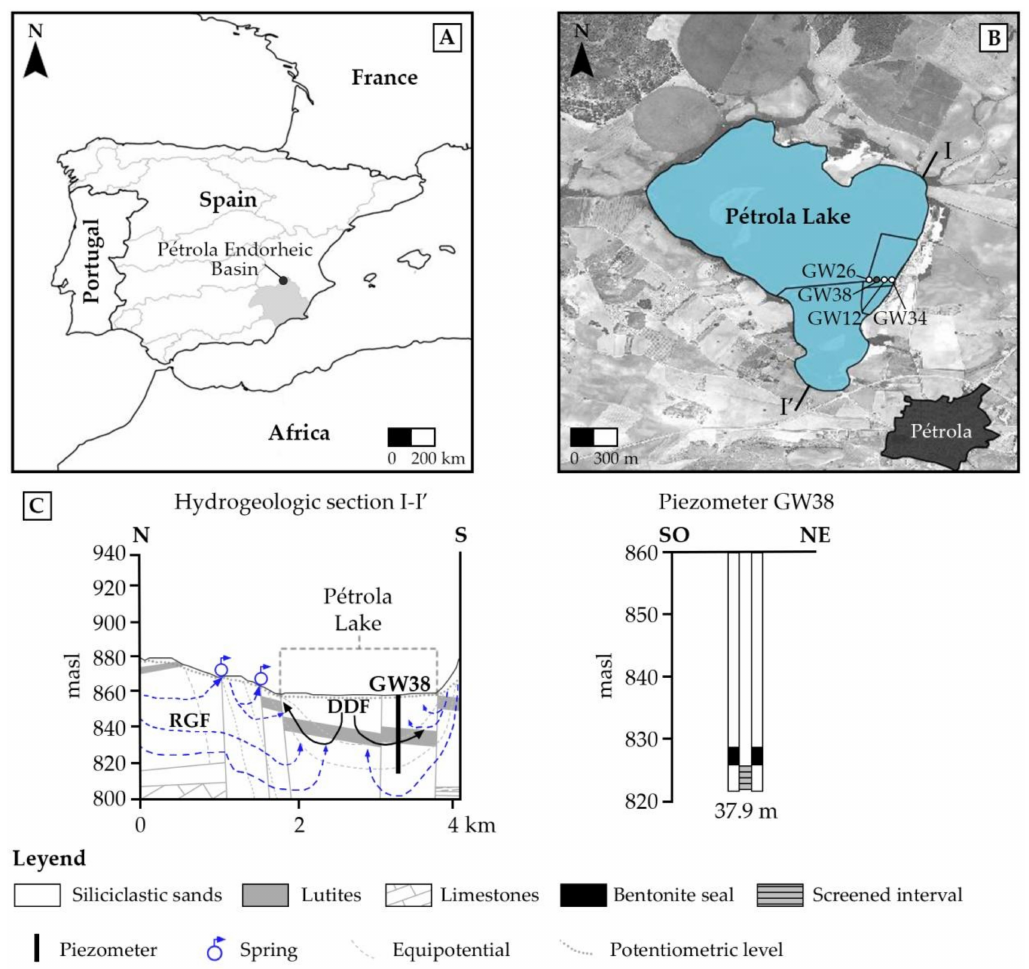
Figure 1. ( A ) Location of the P é trola endorheic basin in southeast Spain. ( B ) Location of piezometers installed in P é trola Lake. The piezometer which withdraws regional groundwater was selected for groundwater sampling. ( C ) Simplified hydrogeological section showing the main groundwater flow components and the allocation of the piezometer GW38. In the same caption is shown the building characteristics of the piezometer GW38 with an indication of the screening zone and sealed